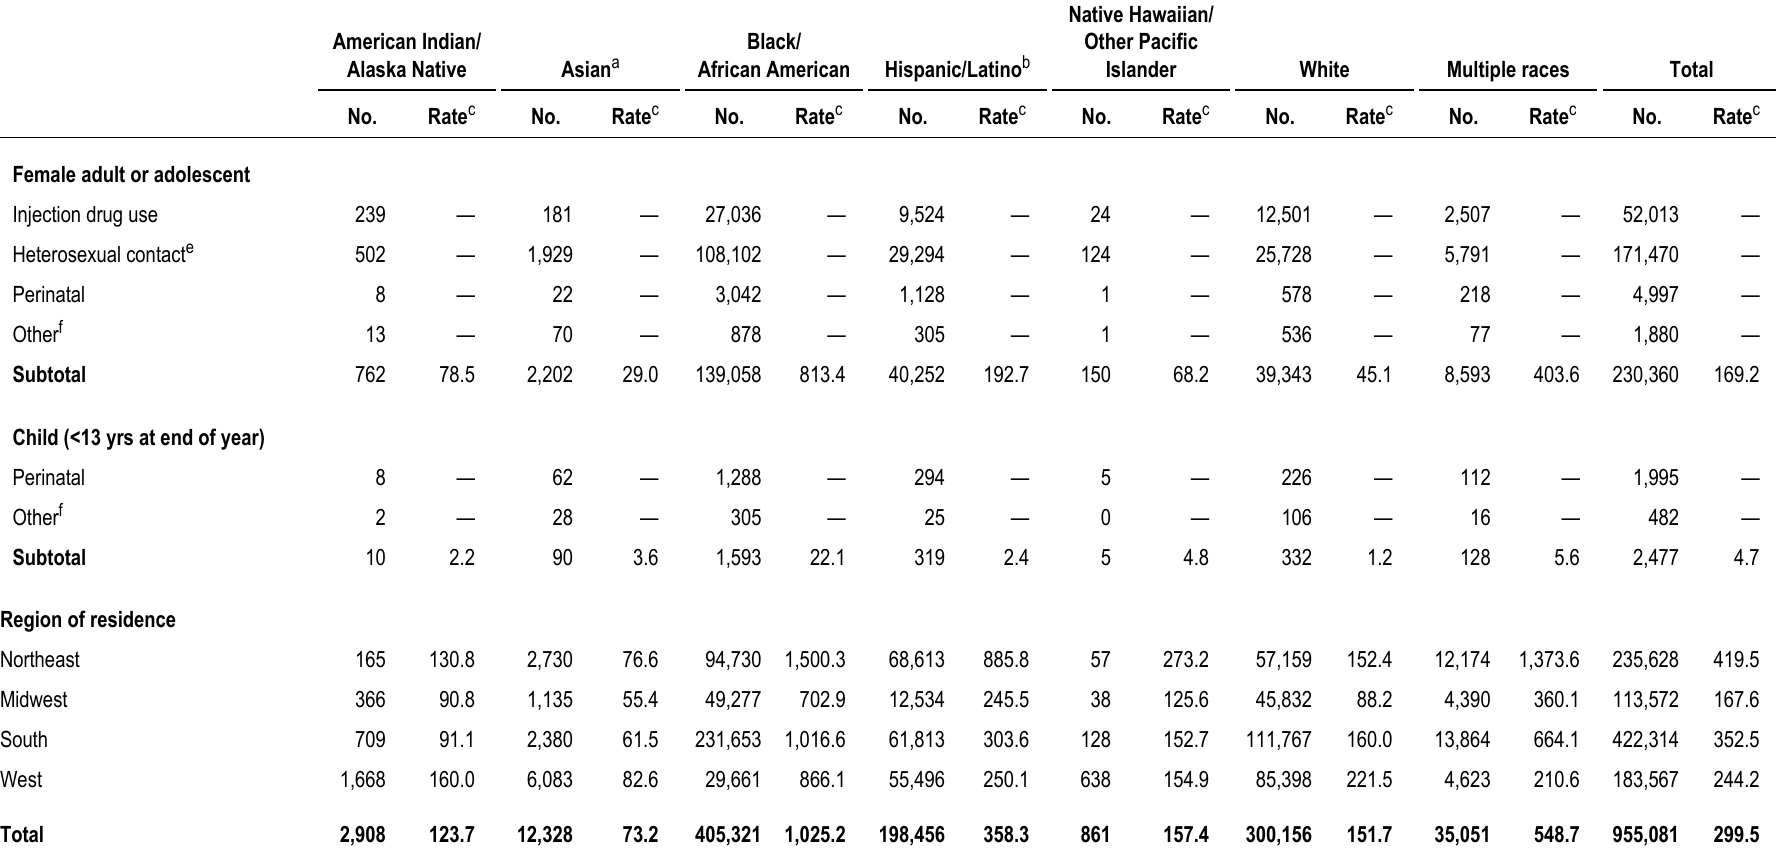
Table 20a. Persons living with diagnosed HIV infection, by race/ethnicity and selected characteristics, year-end 2014—United States